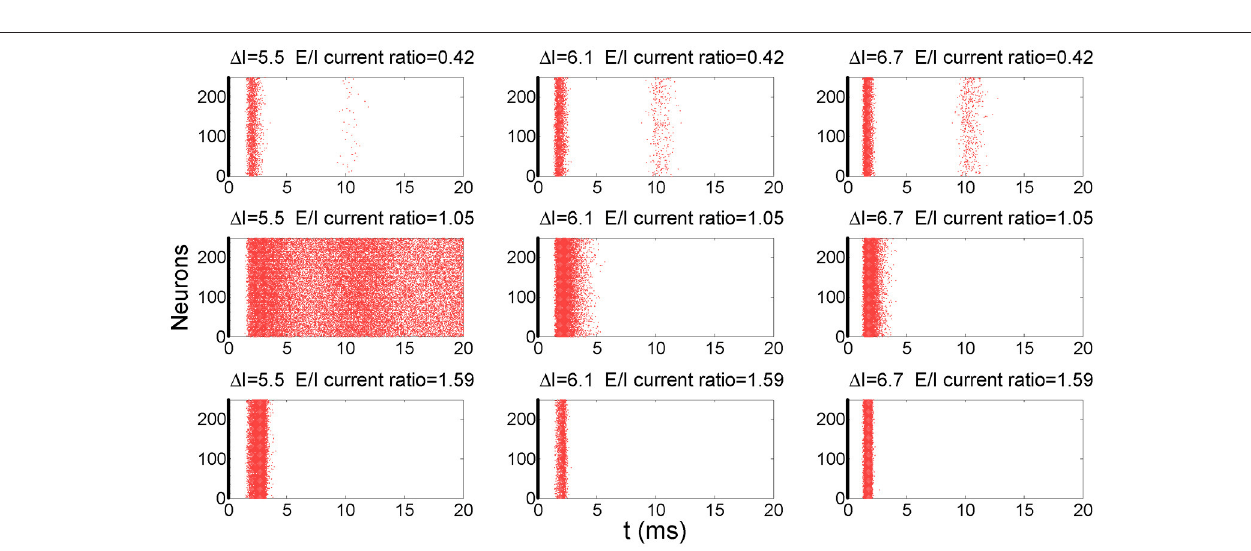
FIGURE 3 | A post-stimulus raster plot of the firing activity in the network for different input strengths and E/I ratios. The thick lines at 0 ms indicate the time instant when the pulse inputs are applied. The raster plots of 100 trials are superimposed to better show the results. D